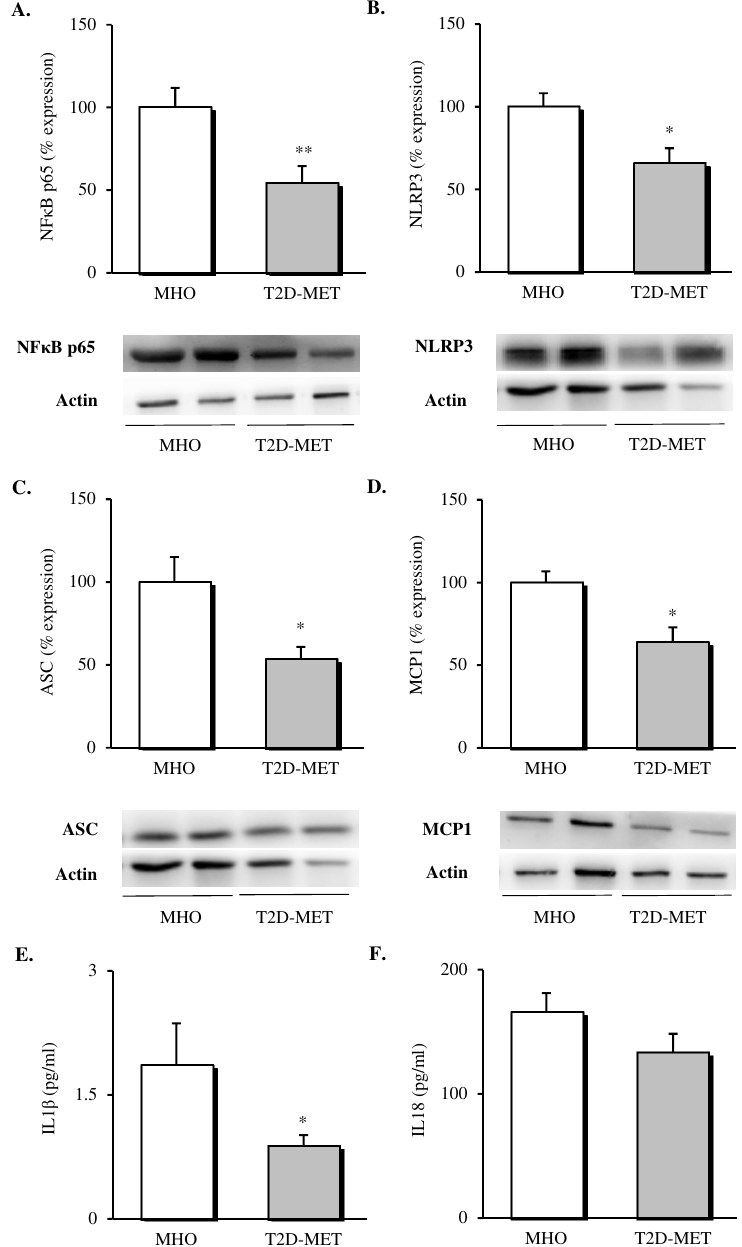
Figure 2. Evaluation of inflammasome complex mediators and interleukins in the VAT and serum of MHO and obese T2D patients treated with metformin. Relative protein expression and